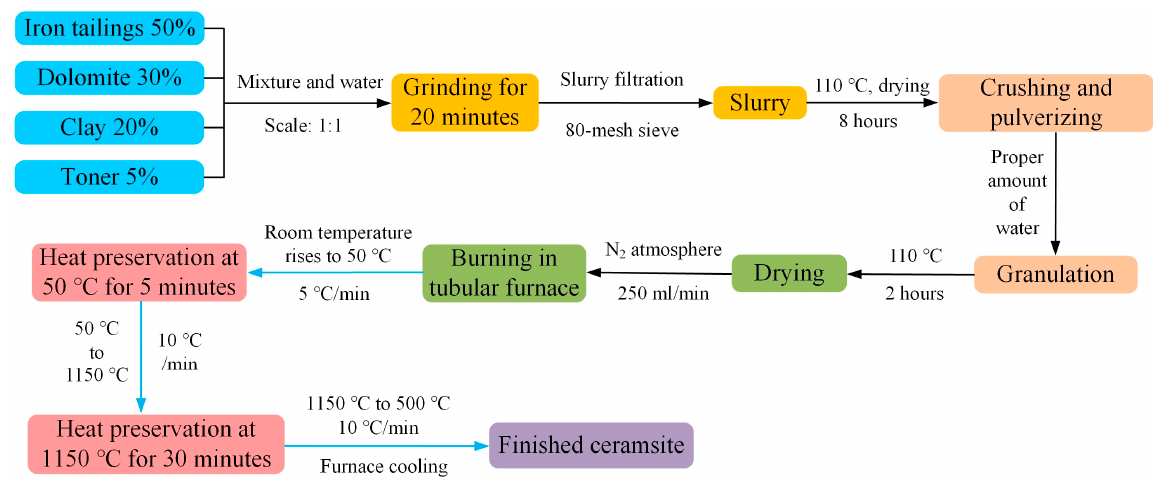
Figure 9. Preparation process of ceramsite.